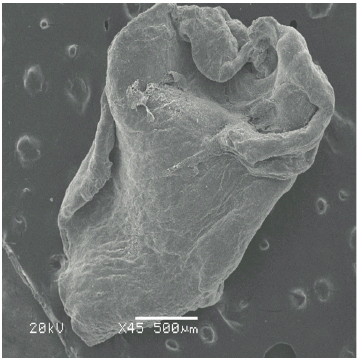
Figure 4: This image shows the surface of a middle ear of a patient with chronic suppurative otitis media. The specimen was used as a control in our study. Note the relatively smooth surface and lack of